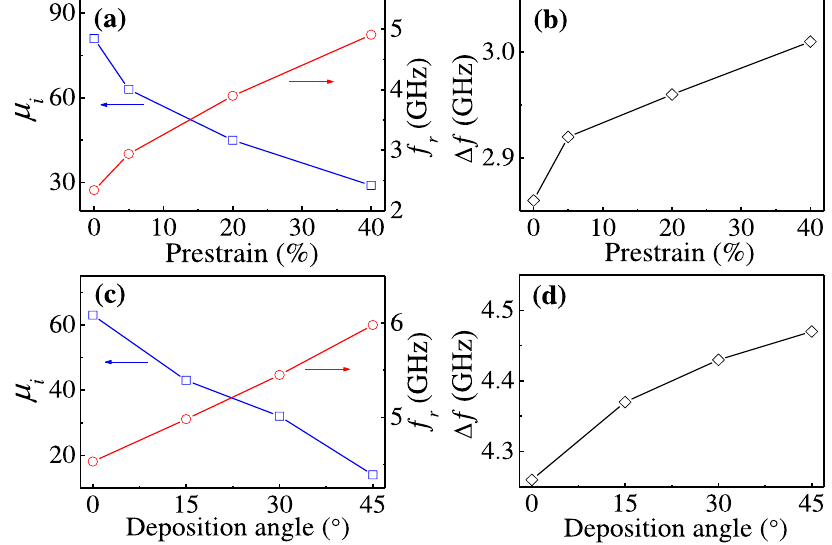
Figure 5. ( a ) Initial permeability, ( a ) ferromagnetic resonance frequency, and ( b ) frequency linewidth for FeCoTa films grown at ϕ = 45° and with different pre-strains. ( c ) Initial permeability, ( c ) ferromagnetic resonance frequency, and ( d ) frequency linewidth for FeCoTa films grown with ε pre = 30% and with different deposition